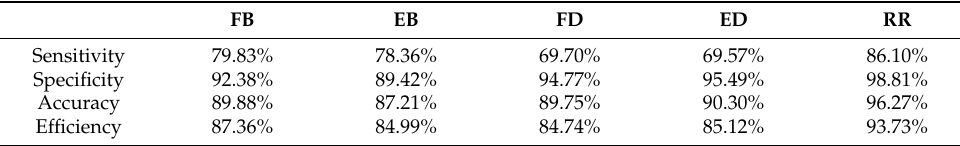
Table 19. Classifier performance parameters for the validation